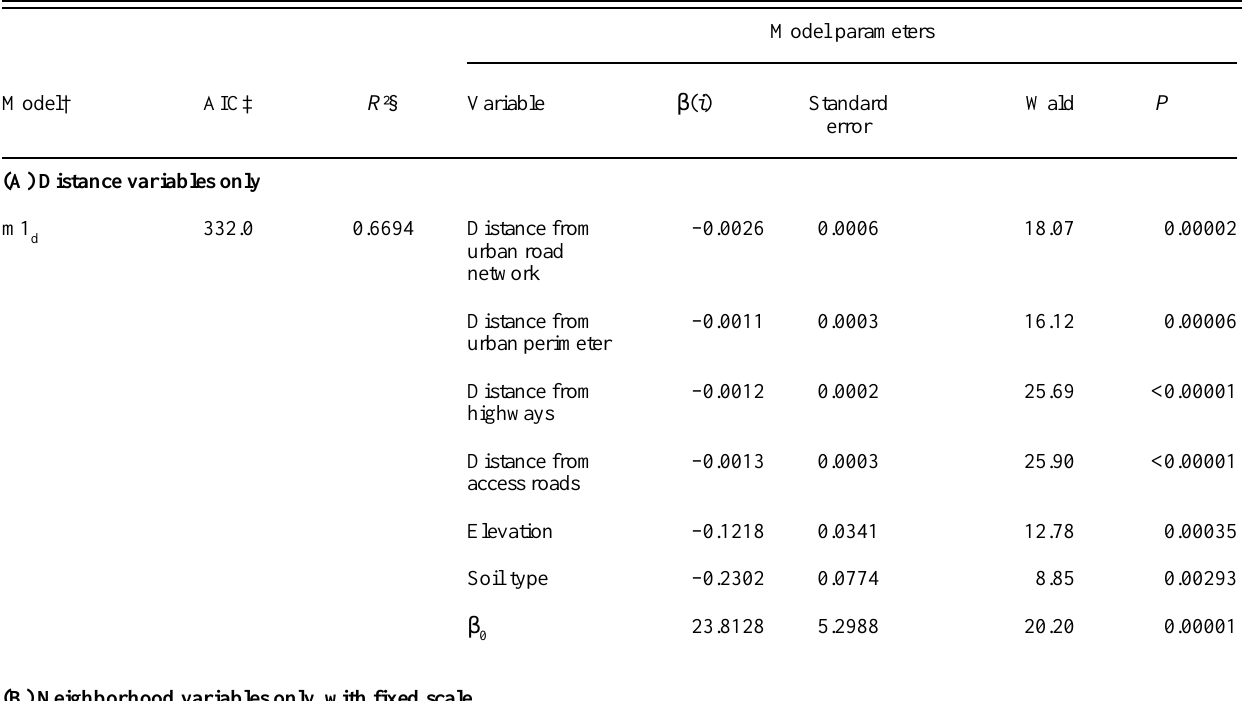
Table 3. Results of the adjustment of the logistic regression using the 3000-m random growth model according to variable